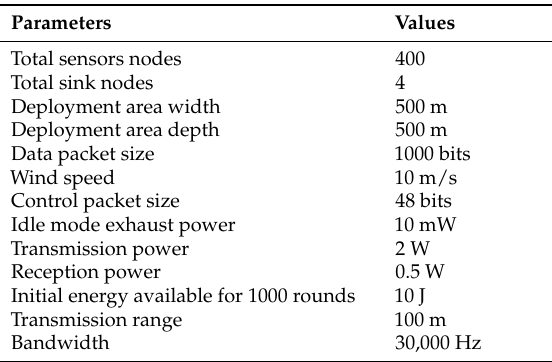
Table 2. Parameters used for